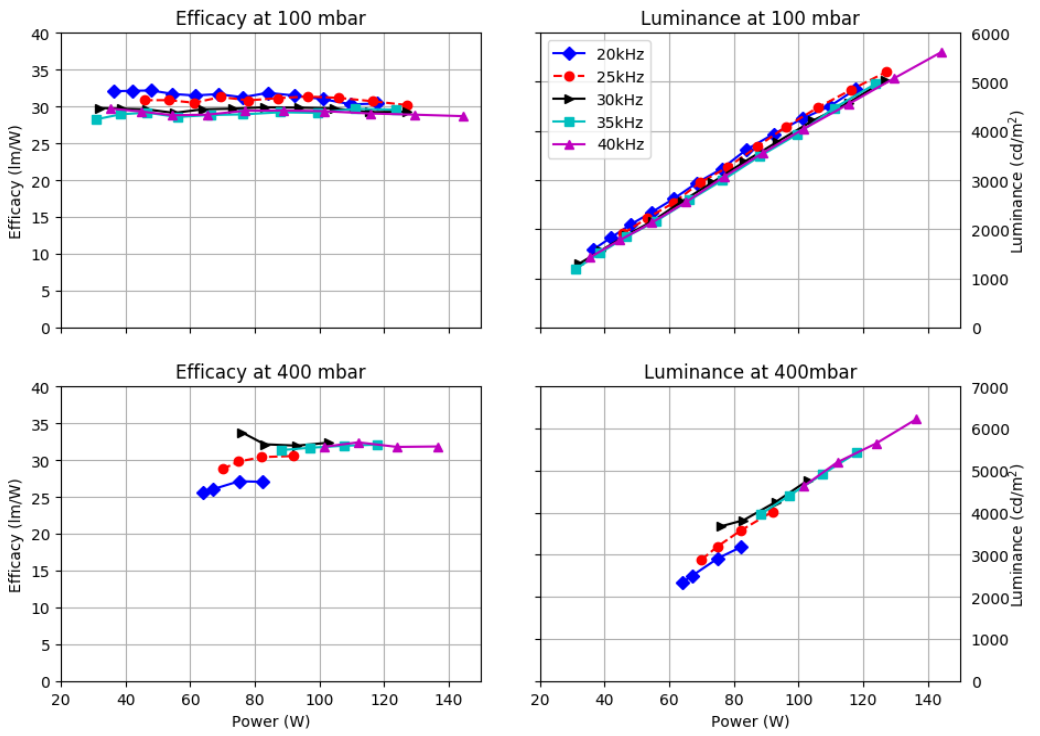
Figure 13. Luminance and efficacies for 100 mbar ( left ) and 400 mbar ( right ) with complementary coplanar geometry electrodes. 10 replicates, standard deviation 10%.